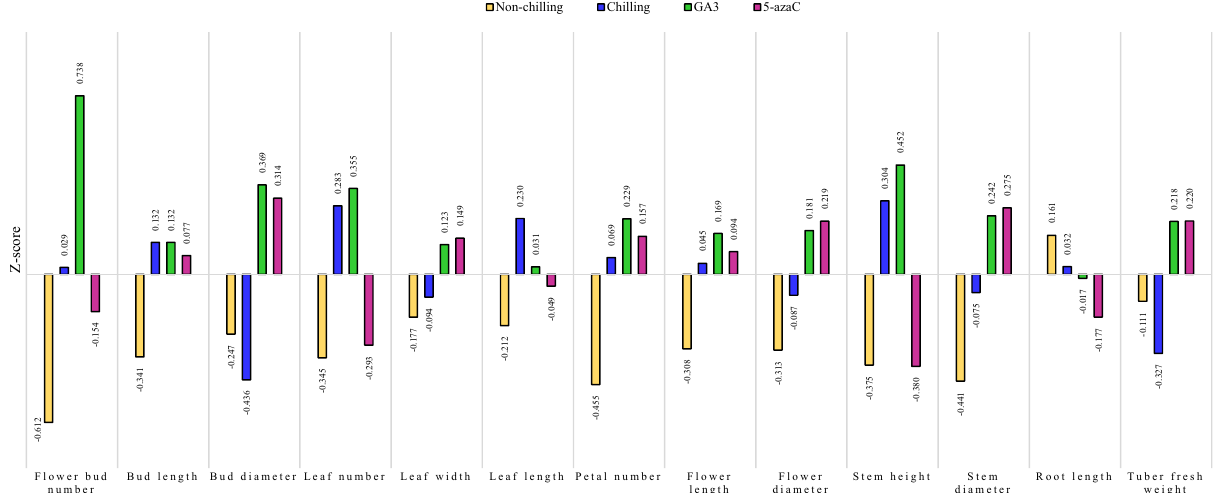
Figure 2. Distribution of the values of the Z-scores for morphological traits under different pre-treatment conditions in 18 studied accessions of Anemone . Z-score was calculated as the difference between the mean of the trait (for each pre-treatment) and the total mean, divided by the total standard deviation (SD). The highest positive Z-scores are associated with the relative highest value of the variable among the conditions. Since increase in the value of morphological traits is a desirable feature, pre-treatments with further positive Z-scores were considered as more favorable for increasing the rate of plant